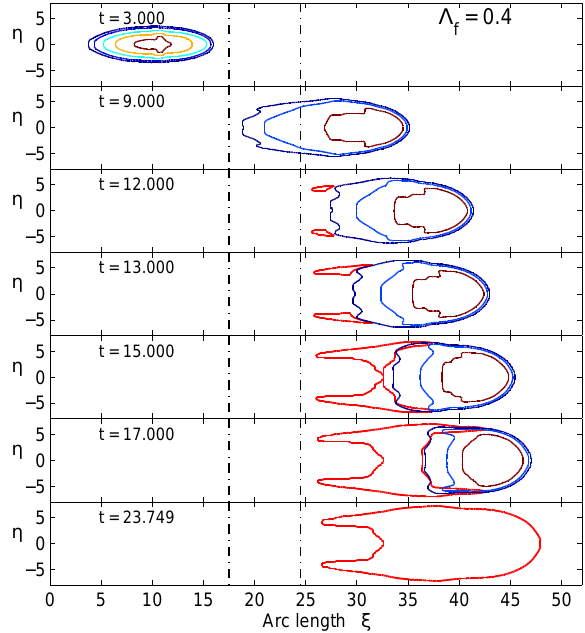
Fig. 6. Contour plots of the flowing mass and the evolution of the deposition heap, where Λ f = 0 . 3 with the deposition procedure be- ing adopted in the computation.